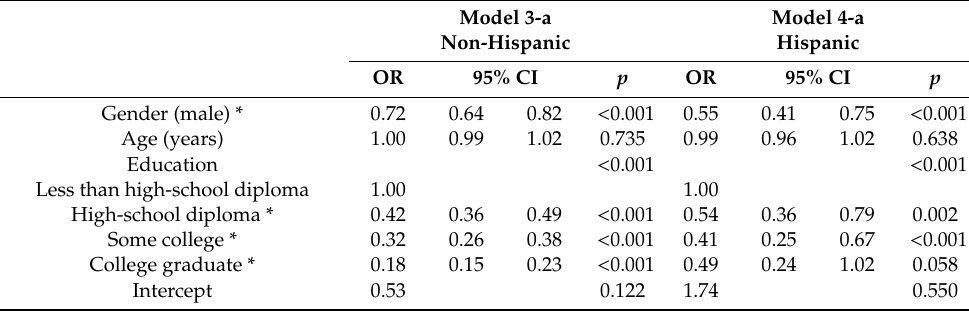
Table 3. Ethnic-specific logistic regressions for chronic depressive symptoms as the